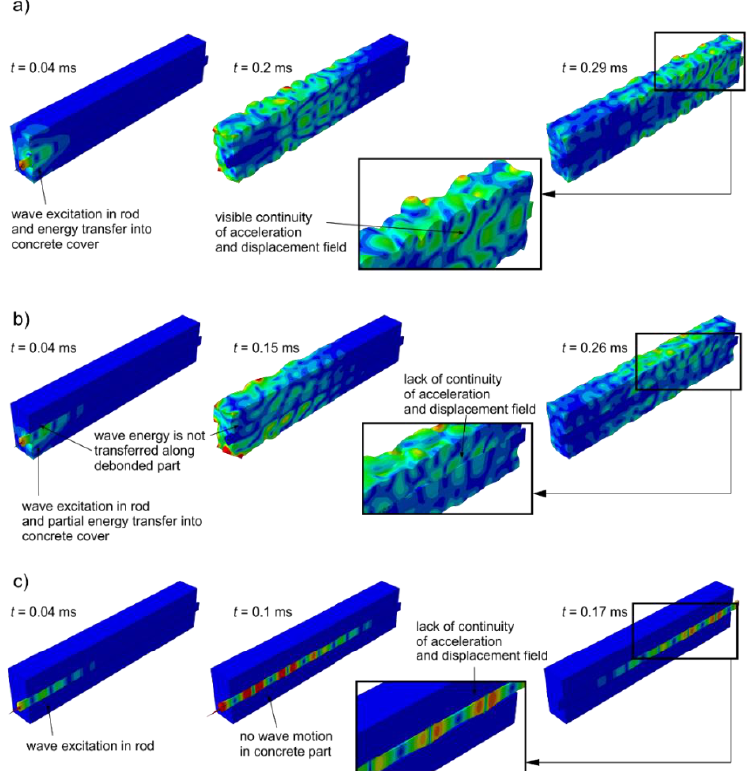
Figure 11. Numerical results of wave propagation in ( a ) undamaged beam and beams with circumferential deboning of extent of ( b ) de = 180° (beam #C) and ( c ) de = 360° (beam #E) for excitation frequency 60 kHz.